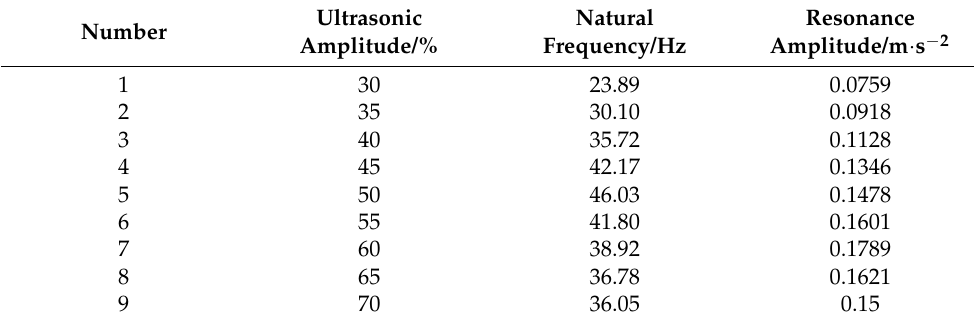
Table 3. Experiment table with abrasive content of 10